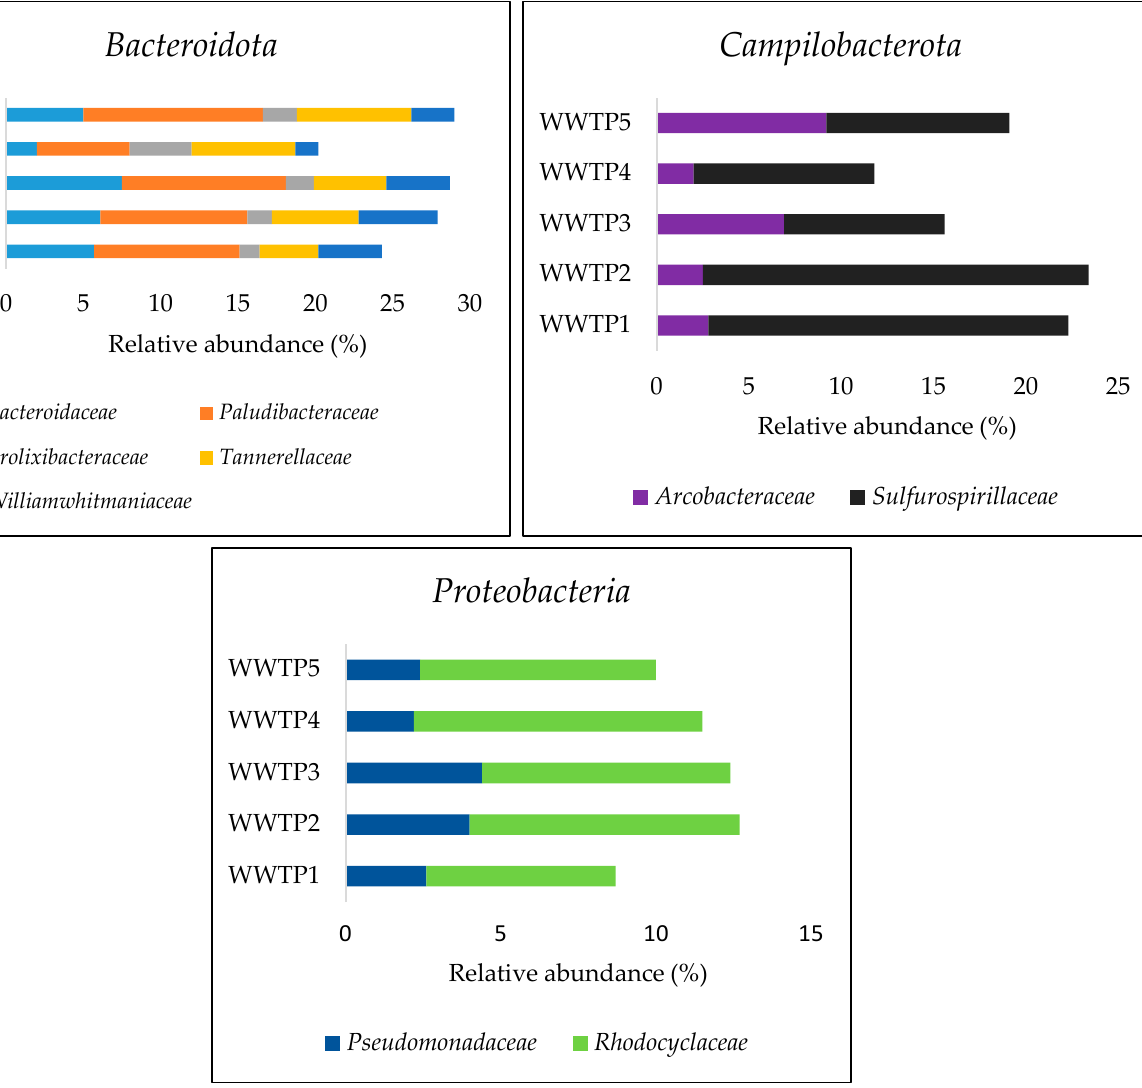
Figure 3. Relative abundance of the families of the top three dominant phyla Bacteroidota , Campilobacterota , and Proteobacteria from the WWTP influent samples.